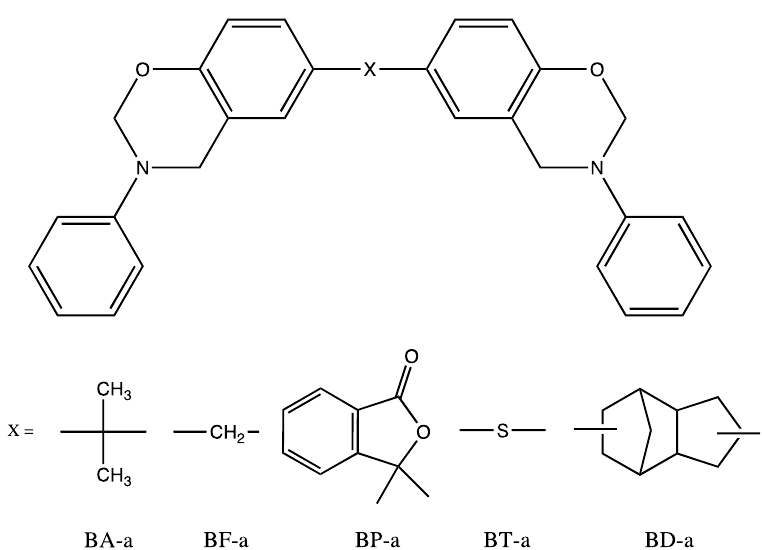
Figure 1. Structures of the monomers. N.B. , BF-a is a mixture of isomers: typically 4,4 ′ -, 2,4 ′ -, and 2,2 ′ -BF-a in the approximate ratio 5:4:1 [10]). Monomer spectral data are deposited as supplementary data.